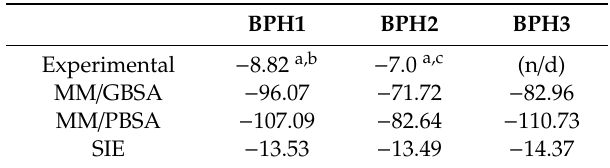
Table 2. Binding free-energy (in kcal.mol −1 ) values obtained from MM/GBSA, MM/PBSA, and SIE approaches in kcal·mol −1 . BPH1 BPH2 BPH3 Experimental